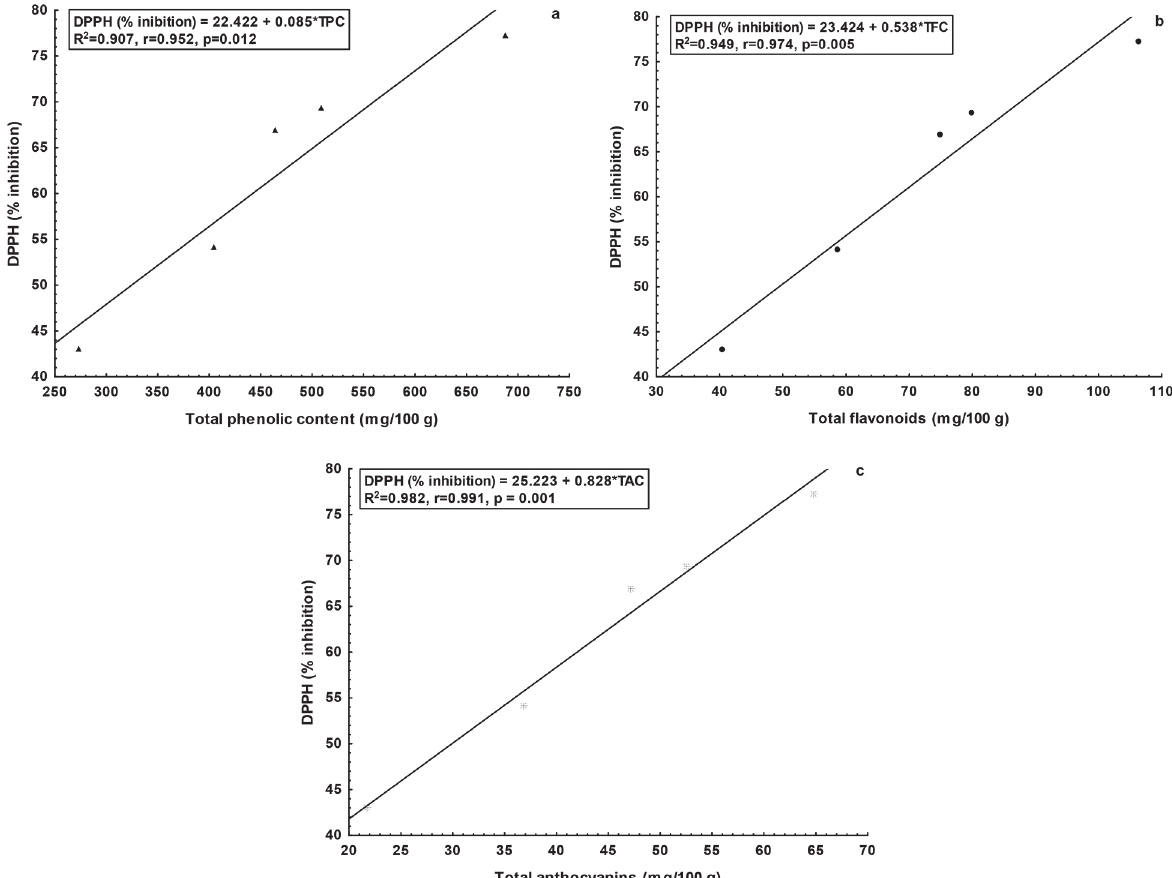
Figure 2 - Regression analysis based on the ordinary least-squares method between the free radical scavenging activity toward DPPH and the total content of phenolic compounds (a) , flavonoids (b) , and total anthocyanins (c) . Note that TPC = total phenolic content, TFC = total flavonoids content, and TAC = total anthocyanins